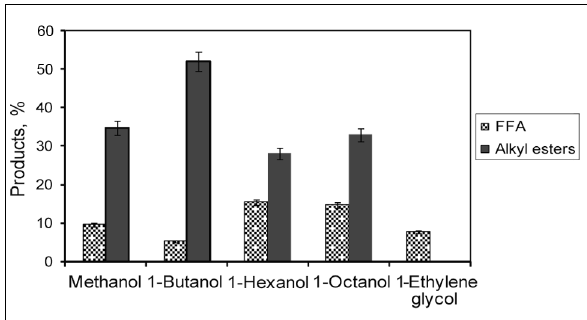
Fig. 1. The effect of type of alcohol used on alkyl esters yield (quantitative analysis, %) and free fatty acids amount (titrimet- ric results, %) released after 96 h during Lipoprime 50T- catalyzed transesterification of rapeseed oil. Reaction was per- formed in n-hexane at 30 °C at rapeseed oil and alcohol molar ratio 1:4